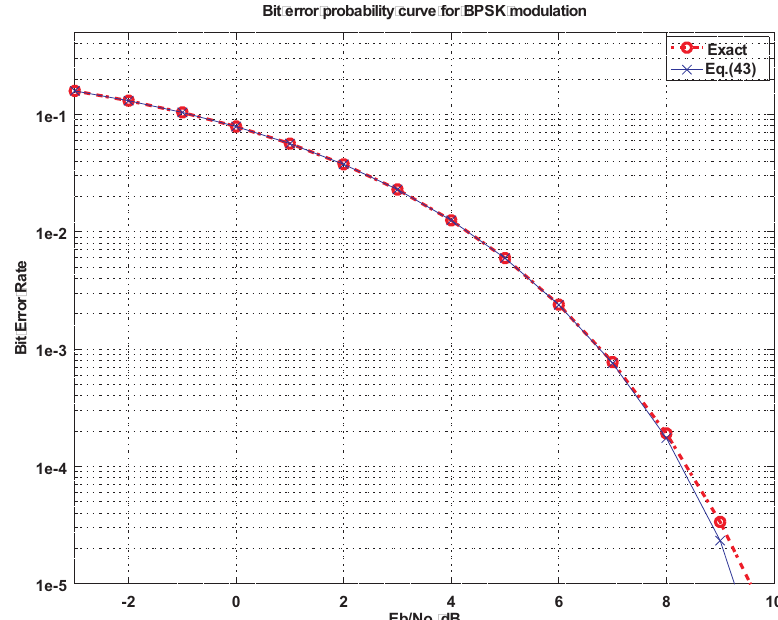
Figure 10: Bit error probability curve for PSK